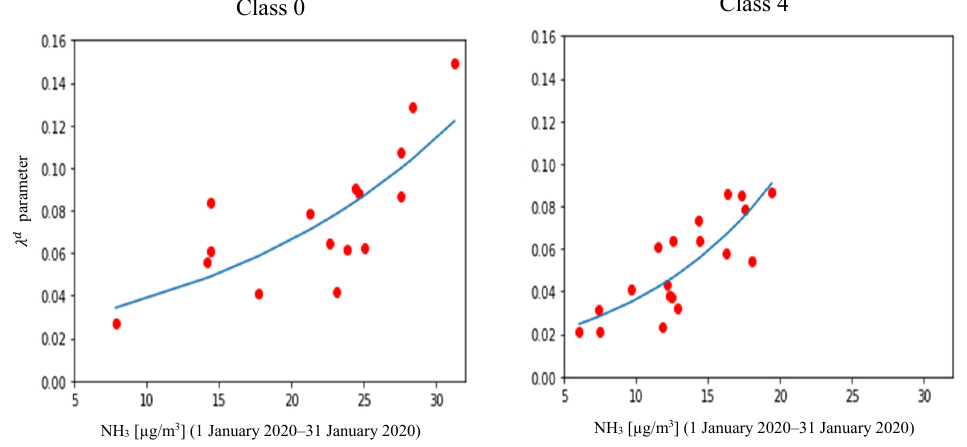
Figure 7. Plots (each red dot refers to one district) of the mean level of ammonia (NH 3 ) recorded in a specific time period against the λ d parameter (estimation of the speed of diffusion of COVID-19; see text for details) for all districts belonging to the same territorial clustering class (areas comparable from the point of view of territory characteristics, see text for details), and exponential regression of data distribution (blue line). Class 0: prevalently agricultural; Class 4: mixed land utilization with prevalent agriculture/natural